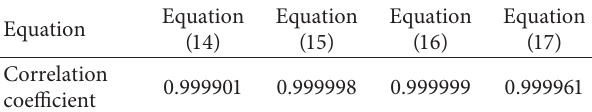
Table 5: The correlation coefficients of each formula.